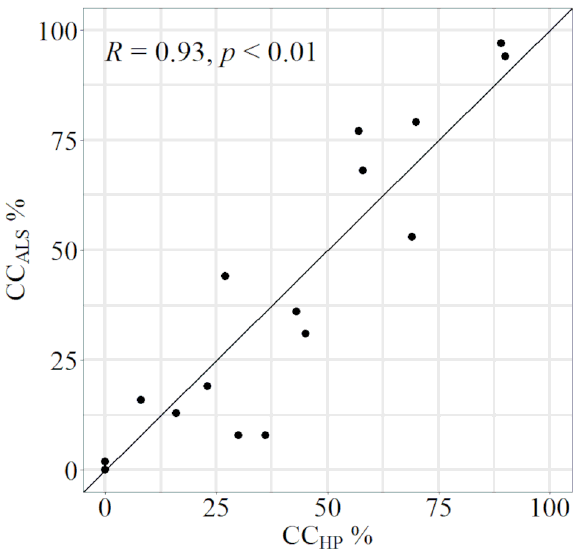
Figure A1. Comparison of canopy cover (CC) percentage retrieved from airborne laser scanning (ALS) and hemispherical photography (HP) with line of